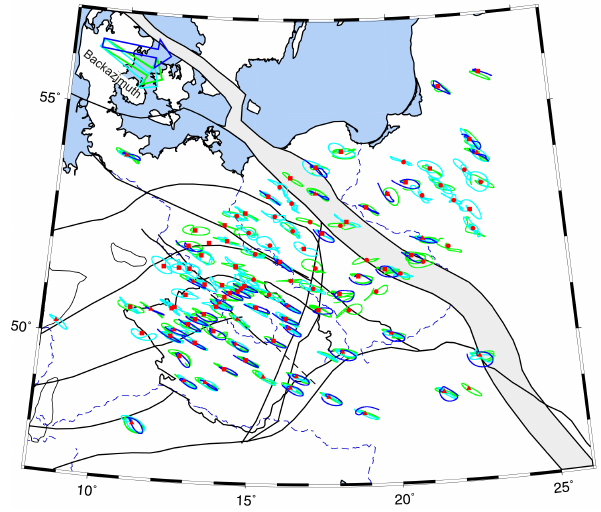
Figure 11. PMs for the same events from the NW as in Fig.